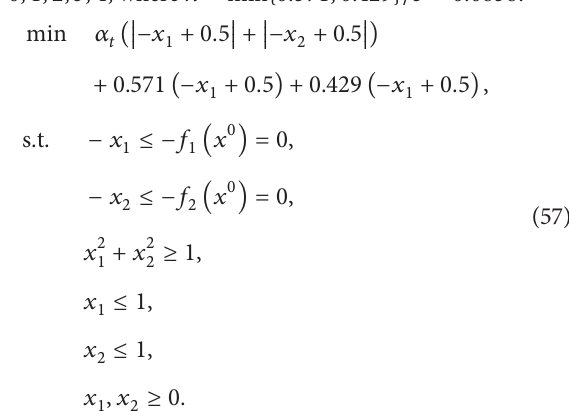
Table 9: The efficient points of the subproblems according to different values of 𝛼 for Example